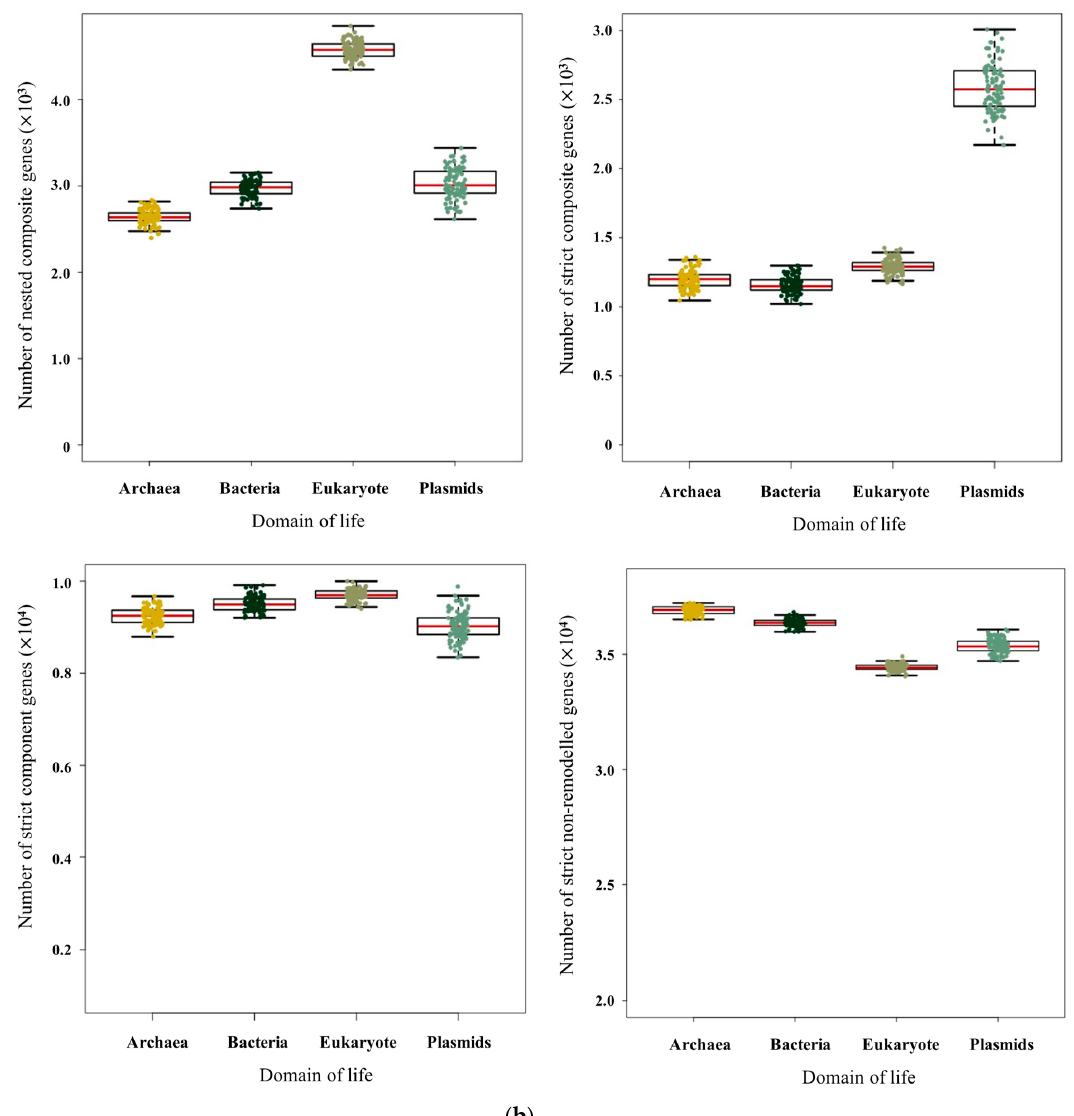
Figure 1. Pictures of composite and component genes among different domains. ( a ) Proportion of composite genes within different domains and mobile genetic elements. Dots represent individual genomes. ( b ) Numbers of nested composite, strict composite, strict component, and non-remodelled genes within different domains for each of the 100 replicates of equal sampling. All analyses were replicated 100 times and each replicate is represented by a dot.